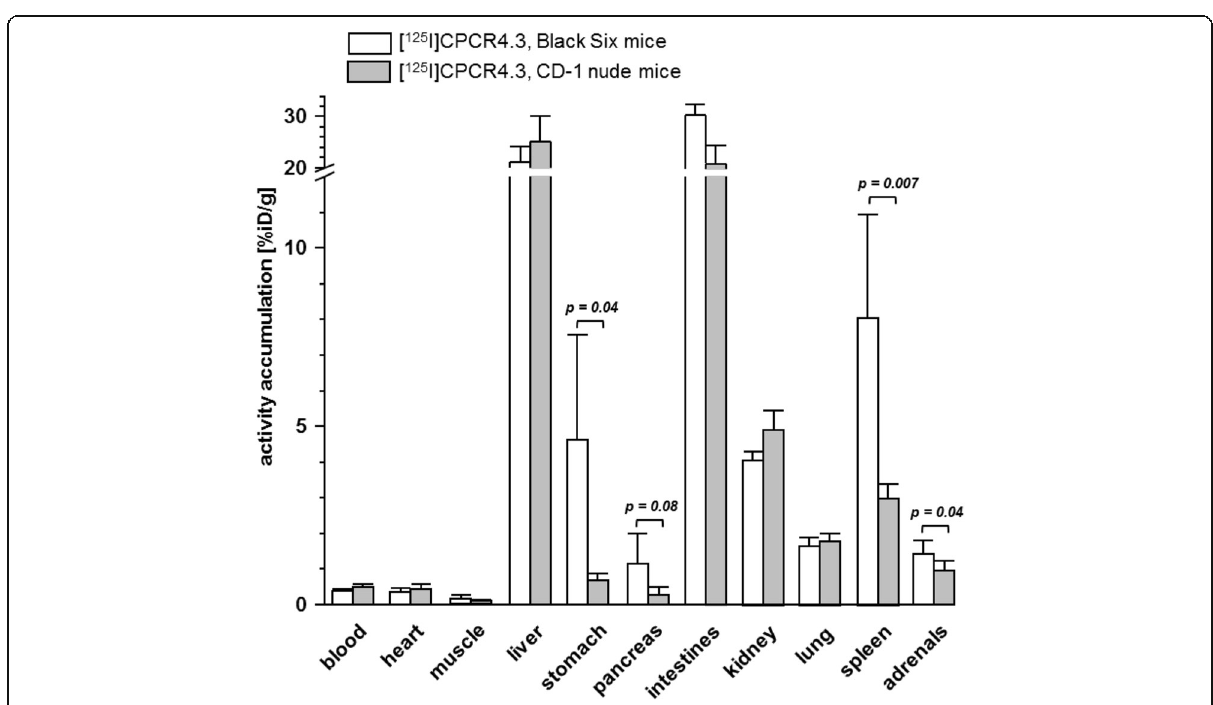
Fig. 4 Biodistribution of [ 125 I]CPCR4.3 in Black Six normal mice and CD-1 nude mice ( n = 5) at 60 min p.i. (groups of n = 4). Data are given as %iD/ g and are means ±